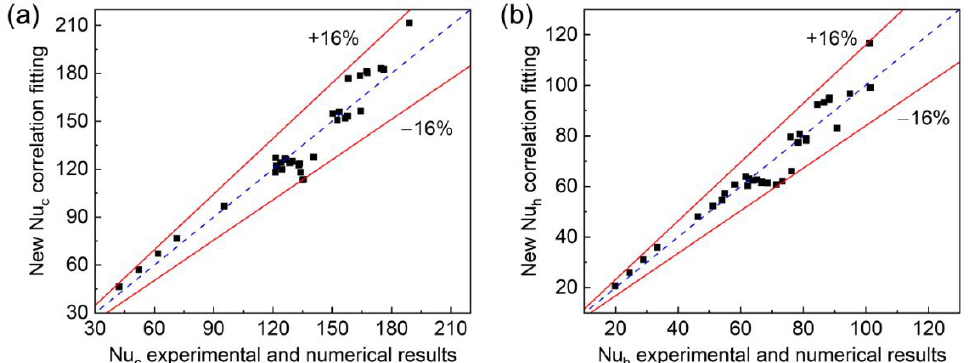
Figure 12. The difference between the new correlations and the experimental and numerical results on ( a ) the cold side and ( b ) the hot